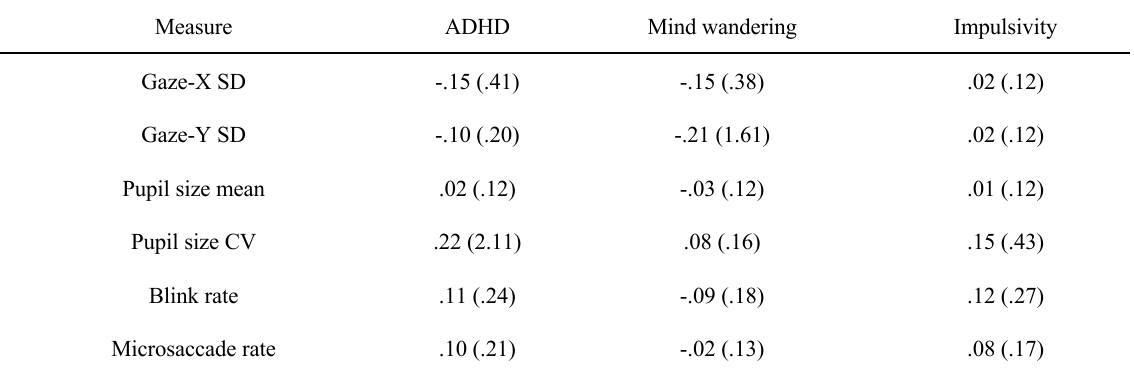
Table 4. Kendall’s τ-values (BF10) between the three questionnaires and the measures of oculomotor variability, combined over the three